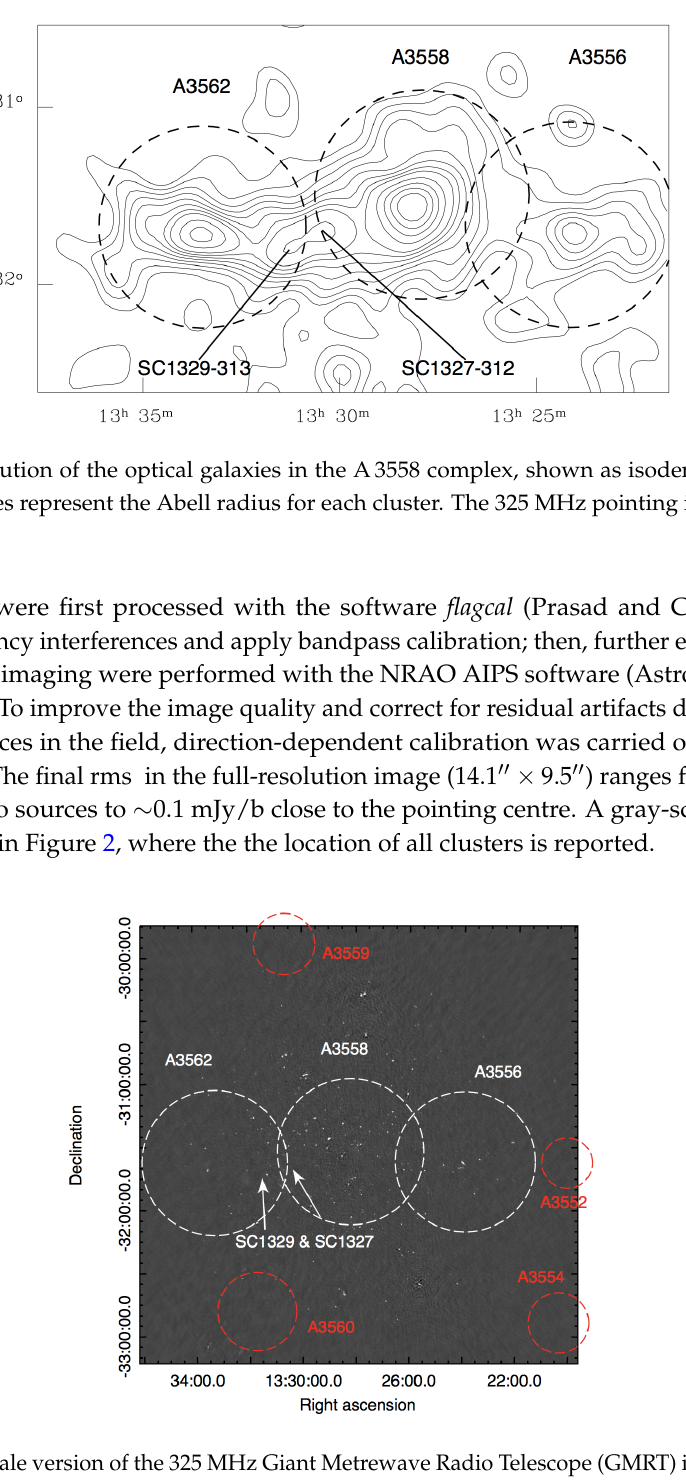
Figure 2. Gray-scale version of the 325 MHz Giant Metrewave Radio Telescope (GMRT) image. The full field of view—centered on A3558—is shown. The Abell clusters and groups are indicated. The restoring beam is 20 (cid:48)(cid:48) × 16 (cid:48)(cid:48)